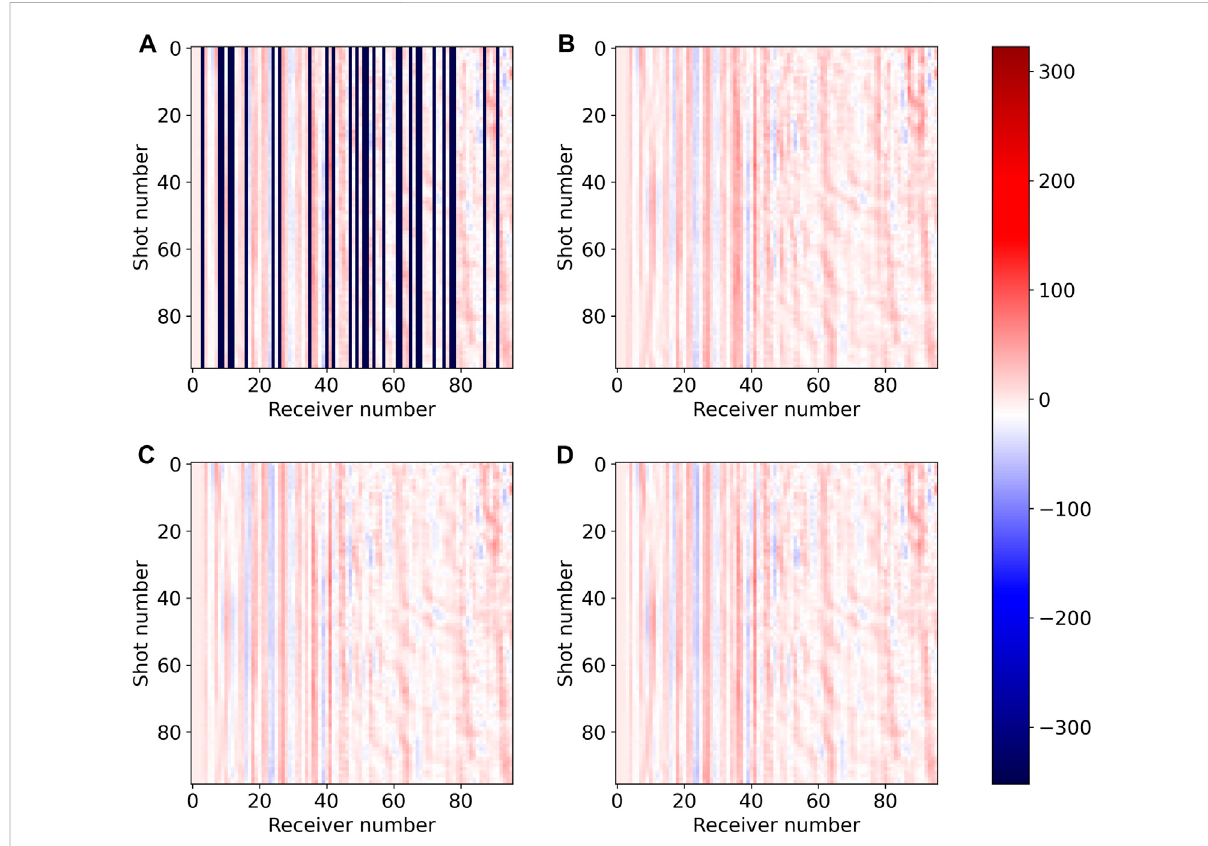
FIGURE 12 Time slice of interpolation results on fi eld data: (A) missing traces data, (B) ground truth, (C) Unet (Chai et al., 2021), and (D)